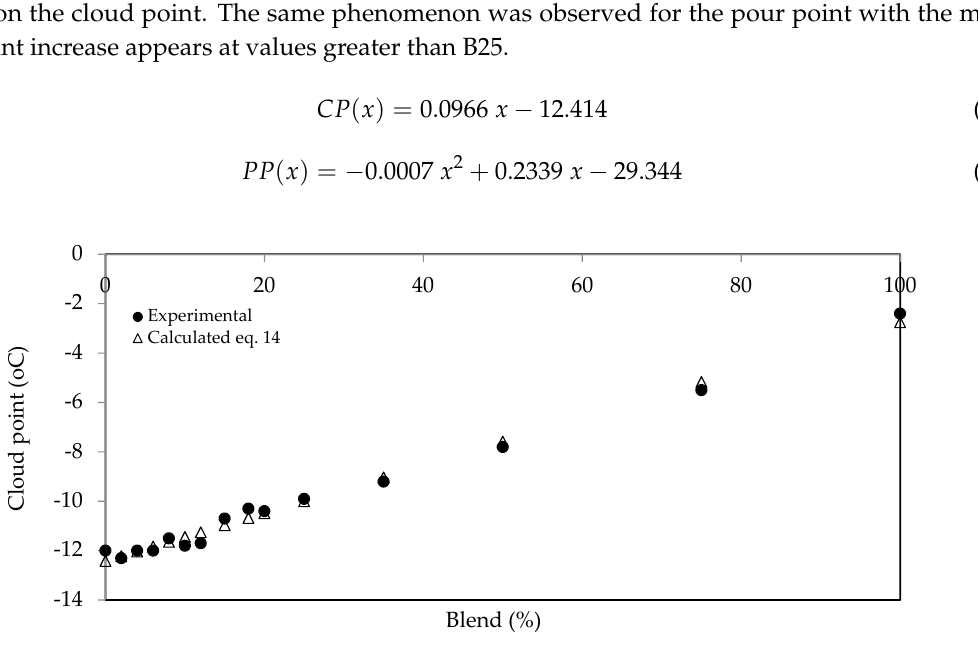
Figure 4. Cloud Point experimental and predicted values.